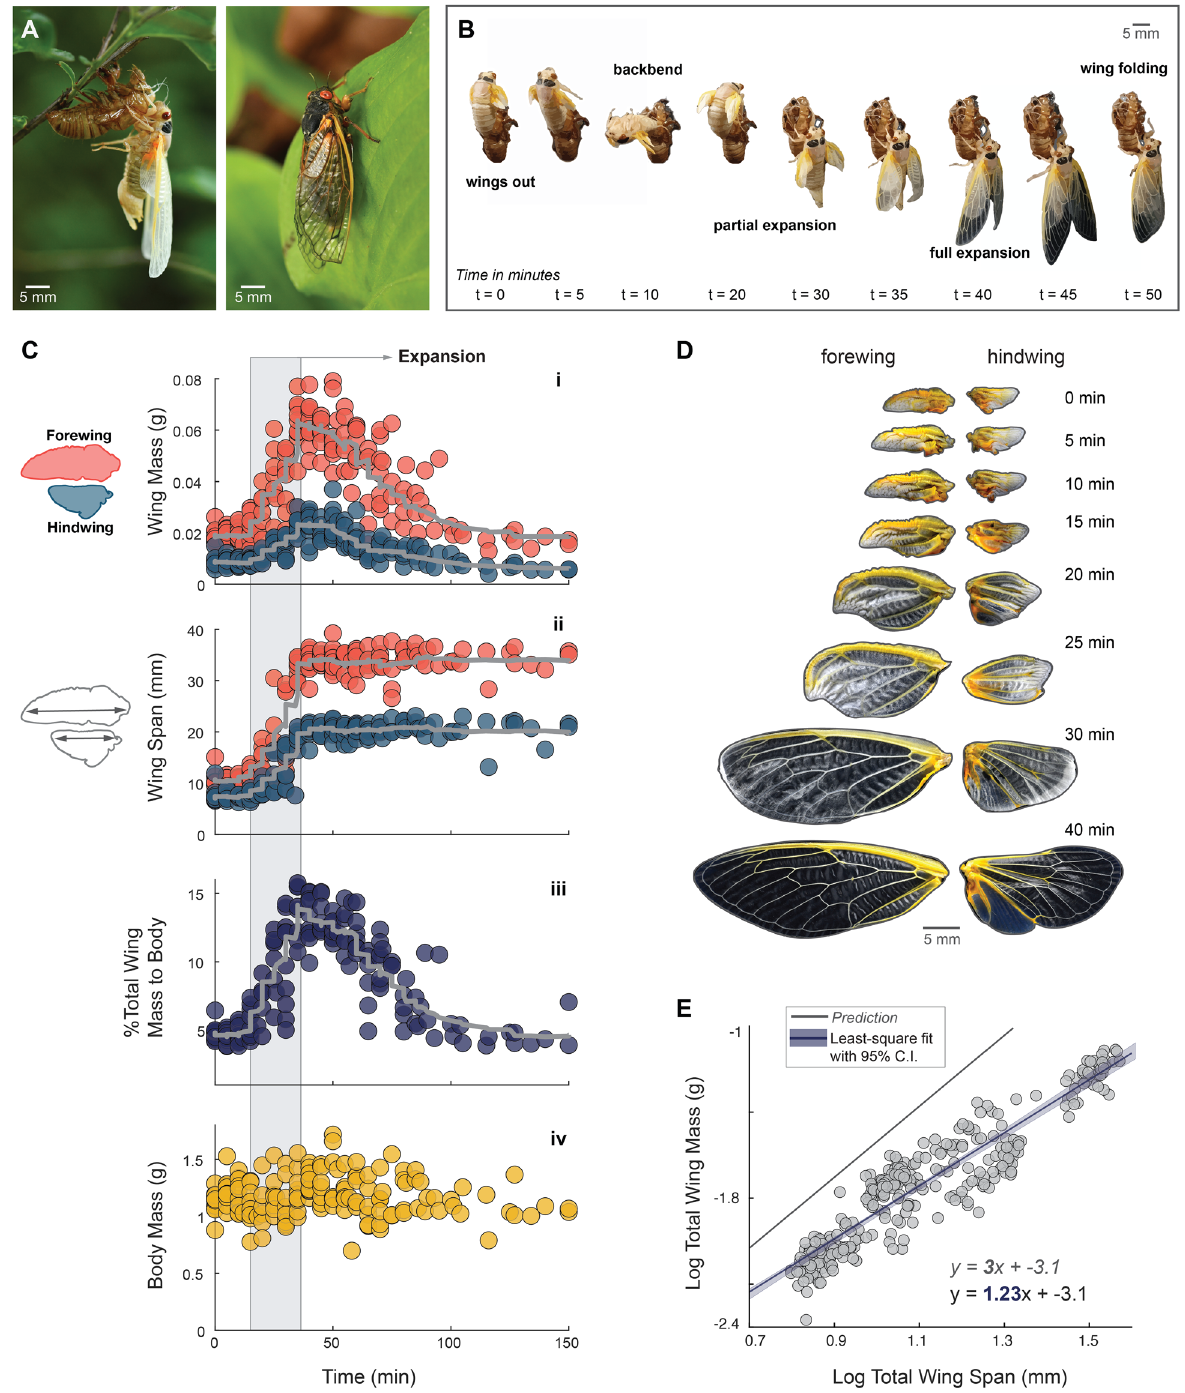
Figure 1. Wing expansion in cicadas. ( A ) Prior to wing expansion, juvenile cicada nymphs crawl up a vertical surface, quiesce, and initiate eclosion, the process of adult emergence (left). Sclerotization and melanization occur over the next 24 h (right). ( B ) To pull out its wings, Magicicada septendecim split the exoskeleton of the thorax and wriggle out. Four wings are freed during this process as the cicada continues to bend backwards. At about 40 min, the wings are fully expanded, and at 50 min they are folded over the abdomen. ( C ) Approximately 800 wings were dissected, weighed, and imaged in 5-min intervals during expansion from wings out (time t = 0 to 120 min). ( i ) Mass was measured immediately after dissection. Wing mass increased up until 40 min, then mass decreased over the next 2 h. ( ii ) Span (i.e., wing length) plateaued at 40 min, measured in FIJI post- experiment (See Fig. 3 for chord and area). ( iii ) At the end of the expansion phase, total wing mass accounts for ~16% of the insect’s mass (relative to body mass). ( iv ) Body mass over expansion. ( D ) Images of dissected fore- and hind-wings throughout expansion. ( E ) Log of the total wing mass versus log of span ( i – iii ) compared predicted isometric versus actual scaling relationships, with a least-squares regression fit and a 95% confidence interval (See Fig. 3 for log of chord and area